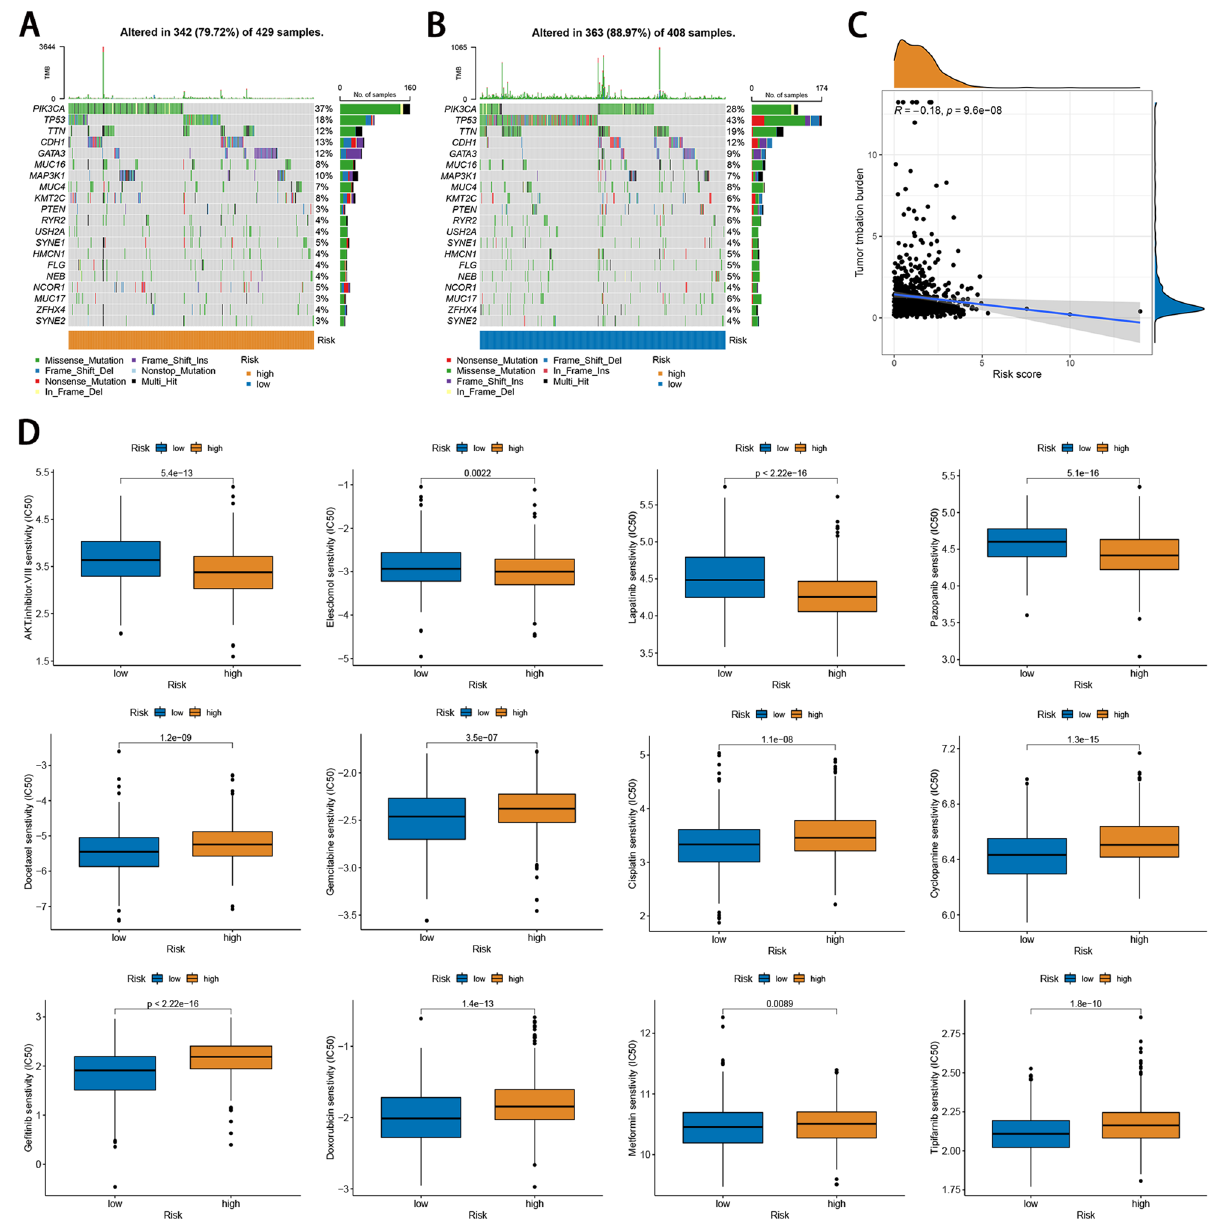
Figure 6. Somatic mutation landscapes and drug sensitivity analyses between high- and low-risk groups. ( A , B ) Waterfall diagram displays the mutation landscape of the top 20 most commonly mutation genes in the high- and low-risk groups. ( C ) Correlation of TMB with a risk score. ( D ) The IC50 values of four chemotherapeutic drugs in the high- and low-risk